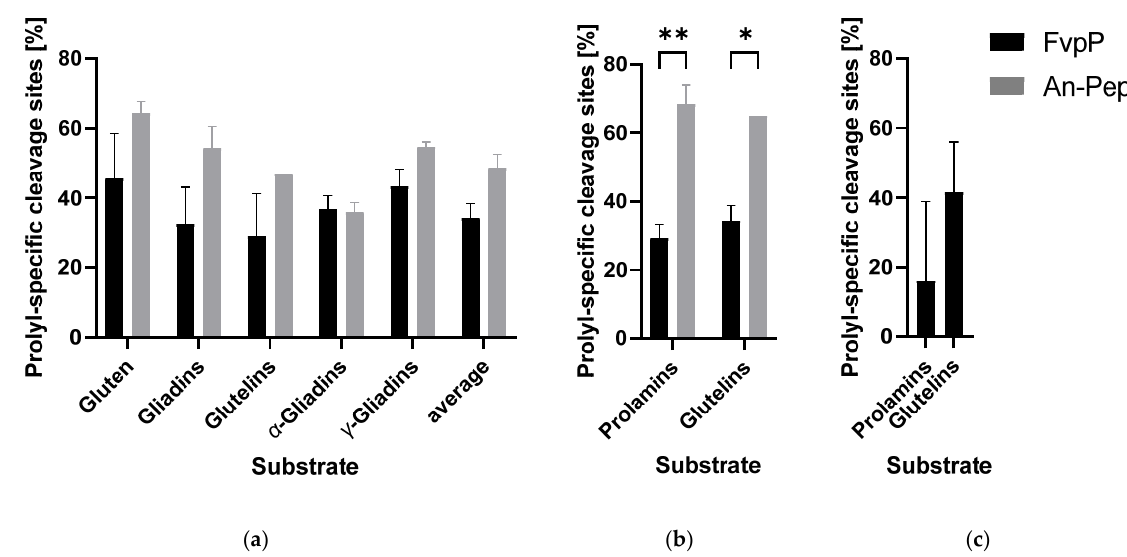
Figure 1. Prolyl-specificity of FvpP and An-Pep for the different flour substrates. ( a ) Wheat and ( b ) rye substrates. The cleavage specificity for the prolamins and glutelins differed significantly between FvpP and An-Pep ( p = 0.0027 and 0.0253, respectively). ( c ) Barley substrates. No proteins of interest were identified in one of the glutelin samples (both wheat and rye) after cleavage with An-Pep. In the barley samples cleaved with An-Pep, no proteins of interest were identified. The remaining data results from two (An-Pep) or three (FvpP) independent cleavage experiments ( n = 2 or 3). Where no significance level is indicated, the differences between the two data sets were non-significant. * p < 0.05. ** p < 0.01.